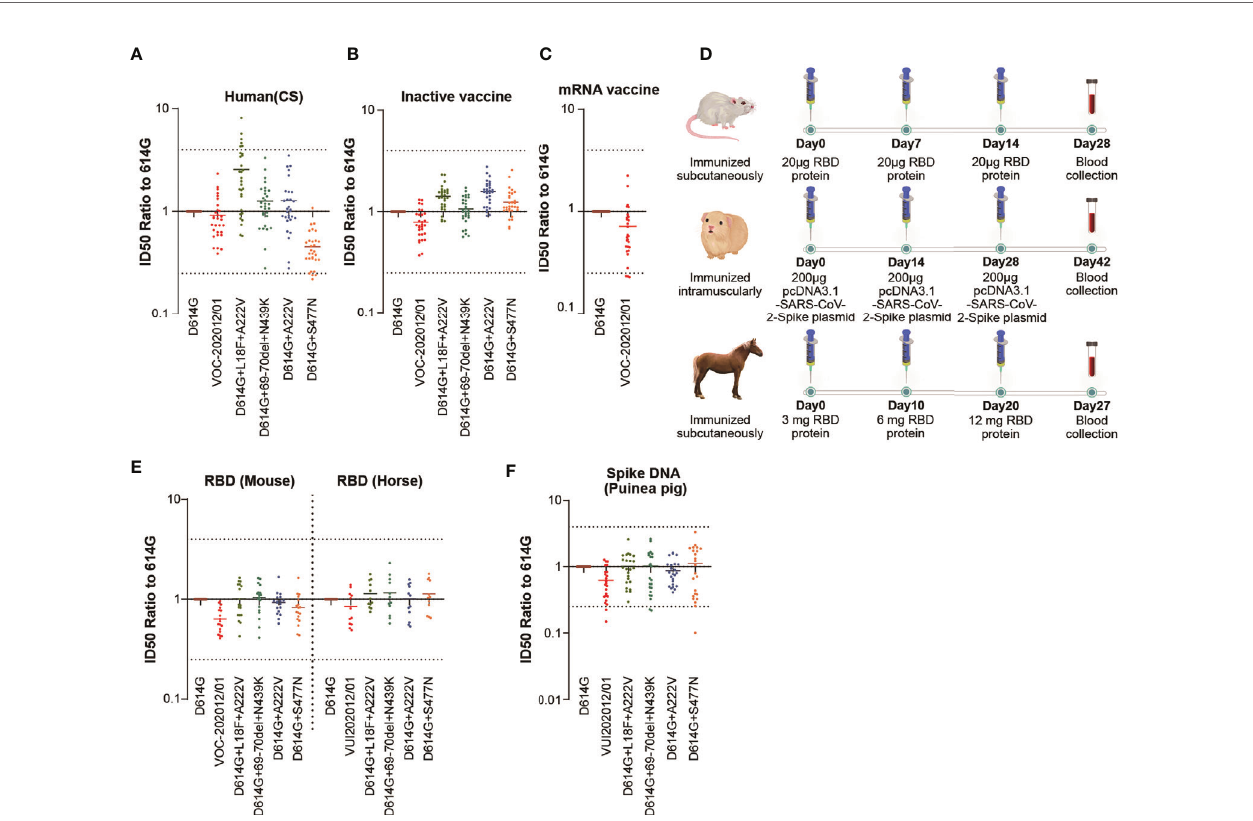
FIGURE 3 | The neutralization activity of polyclonal Abs against the fi ve epidemic variants. Sera were serially diluted and the other procedures were the same as described for Figure 2A . Scatter plot of (A – F) showing the neutralization ID 50 ratio of each variant to that of D614G. Each point represents a single result, and the dashed line represents the mean value. The results are a summary of at least three repeated experiments. The dotted line represents 4-fold changes. (D) showed the animal immunization